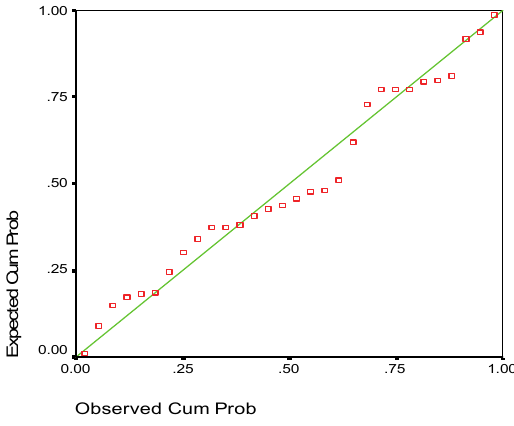
Fig. 2. The spread of the relationship between the dimensions of IS success factors on user